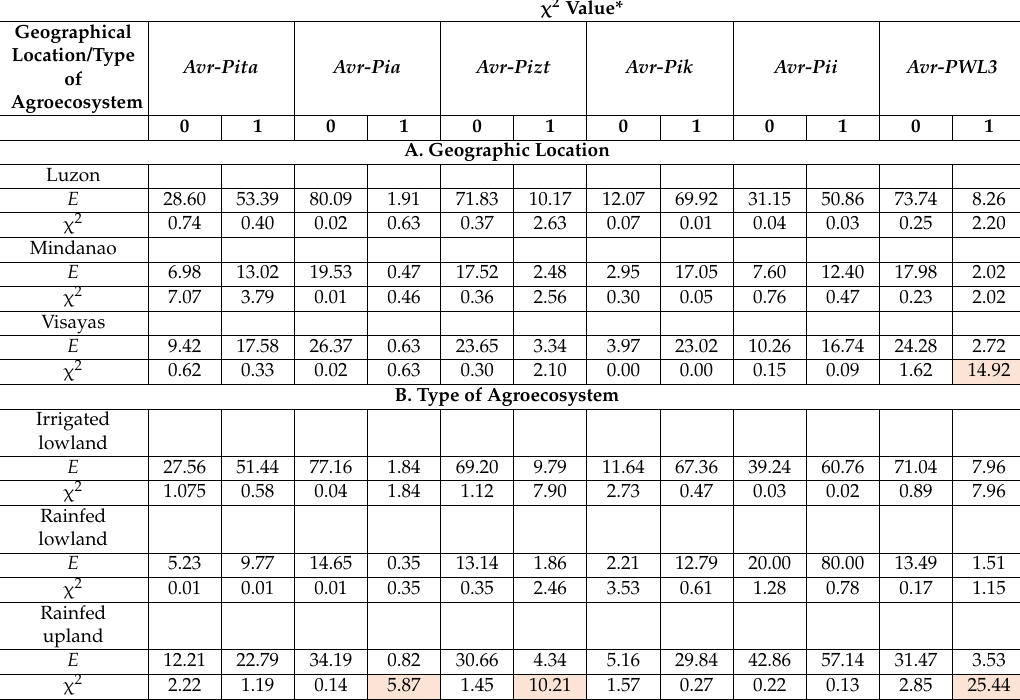
Table 2. Expected frequency ( E ) and computed chi-square ( χ 2 ) values for the presence (1) and absence (0) of a specific avirulence gene in M. oryzae isolates against geographic location and type of agroecosystem. χ 2